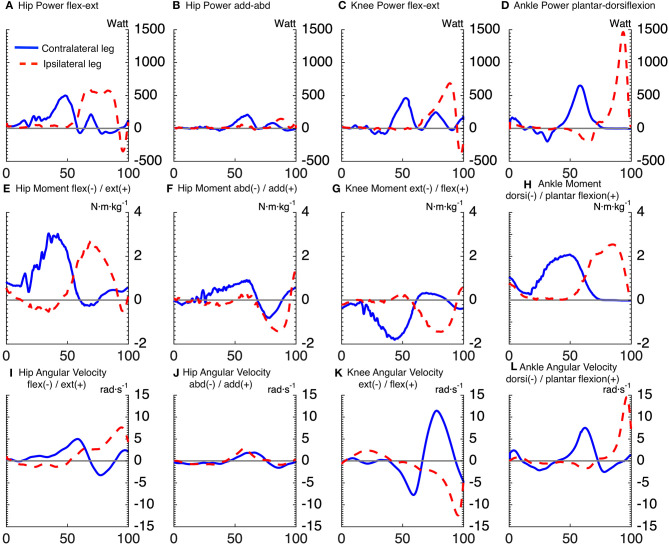
Time series averaged over subjects, for joints powers (A–D), joints moments (E–H), and joints angular velocities (I–L), of goalkeepers diving to save high balls. Solid lines correspond to the contralateral leg, and the dashed lines to the ipsilateral leg. The x-axis of all subplots is the normalized time expressed in [%]. The titles (A–D) of joints powers indicate the plane of movement of the joint and not the direction of joint rotation. The sign of joints powers reflects power generation (+) and absorption (-).